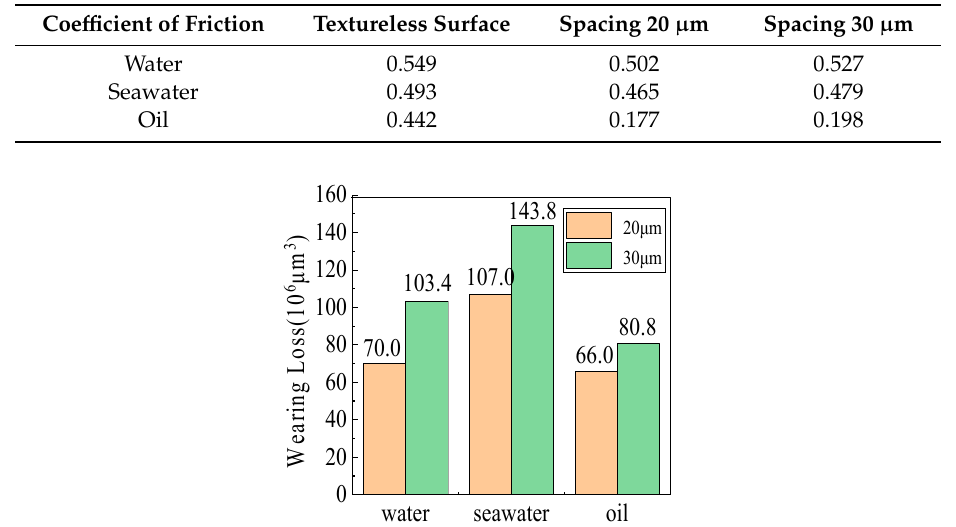
Figure 8. Wear loss of pit surfaces with different spacings.